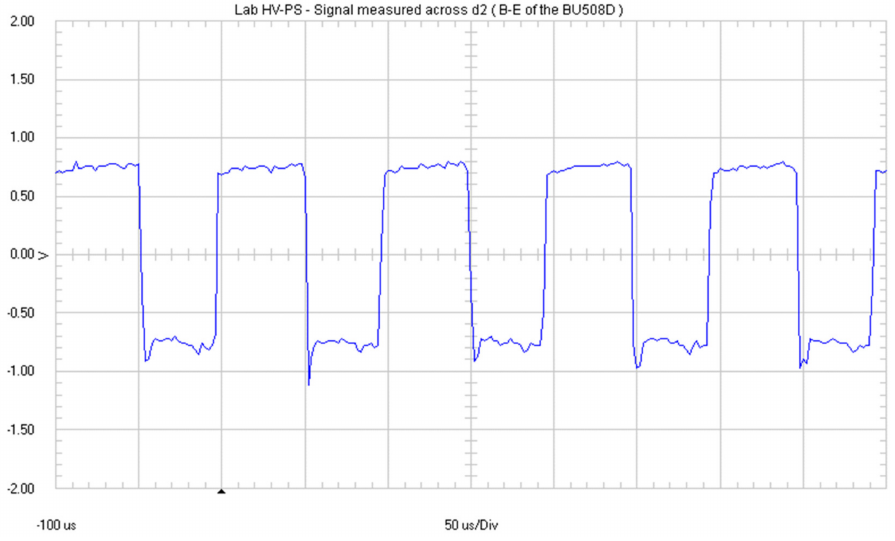
Figure 6. The signal measured across the output power